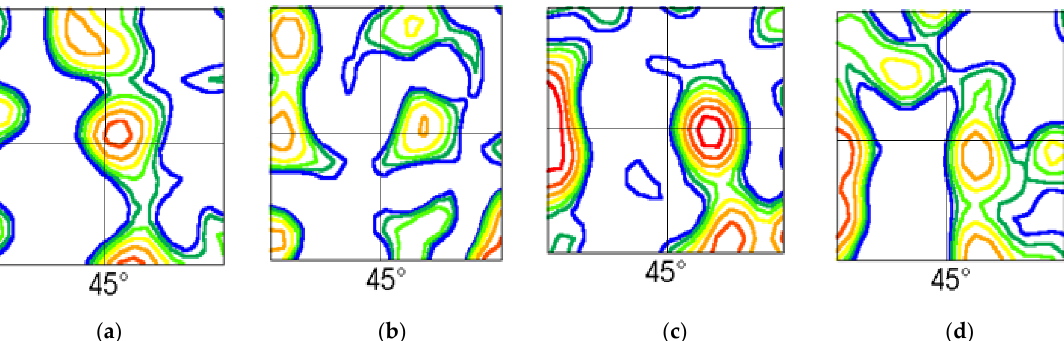
Figure 10. Typical ideal orientation observed after ECAP passes. ( a ) No pass, ( b ) first pass, ( c ) second pass, ( d ) third pass at ambient temperature.